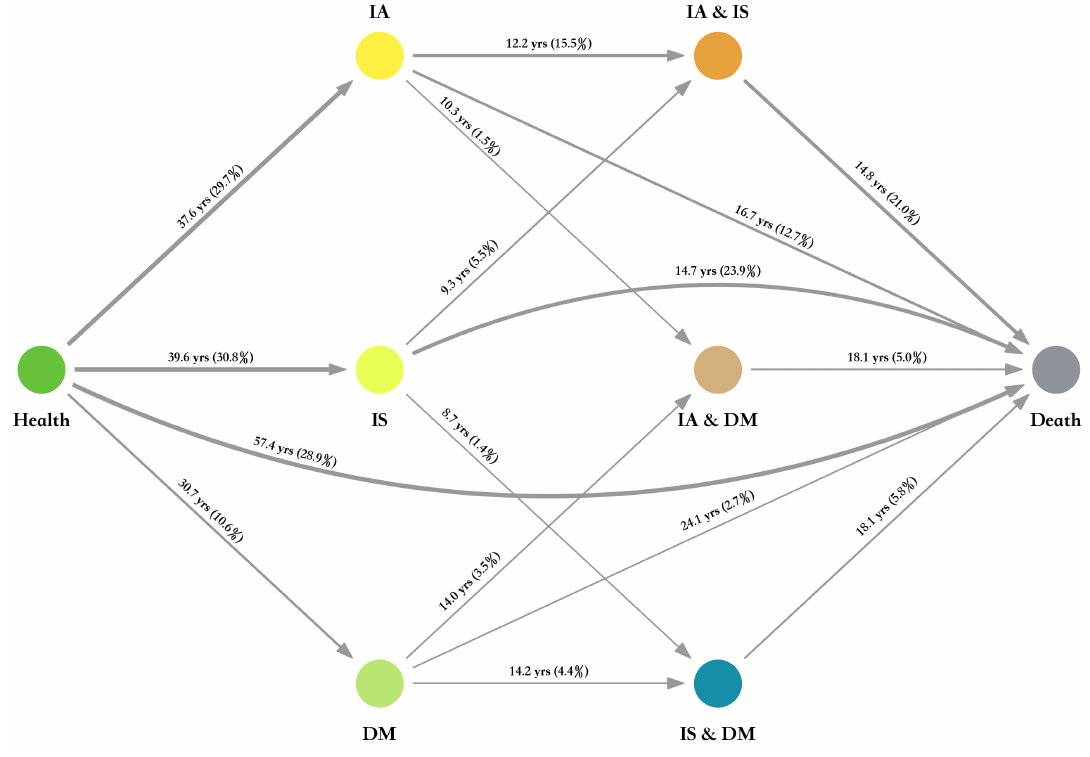
Figure 8. Overall disease metastasis of 1-year interval group.